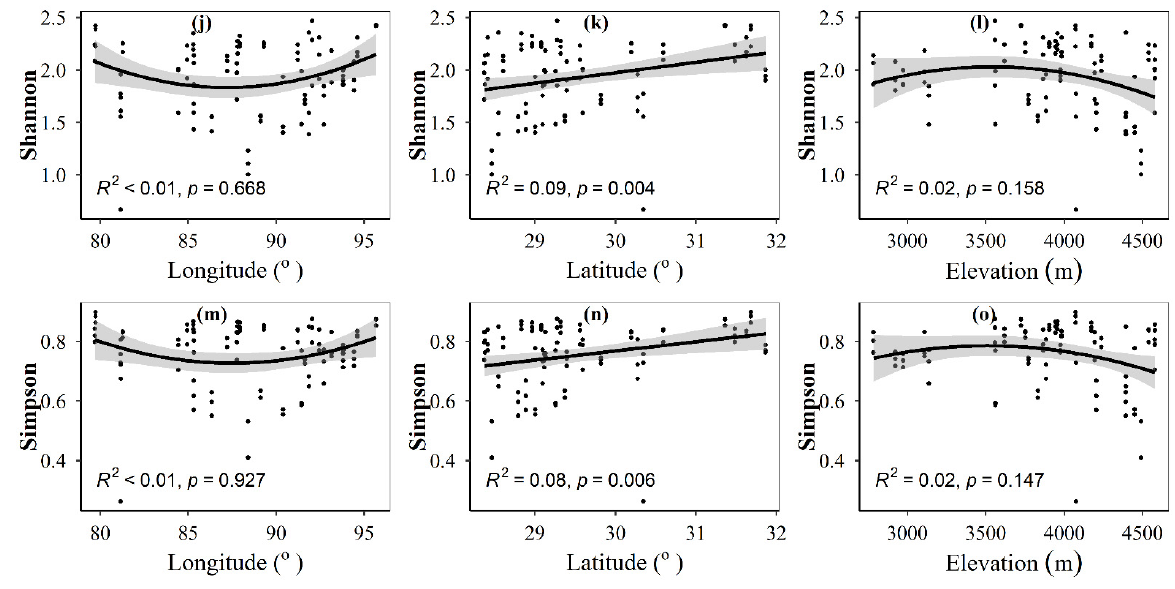
Figure A15. Relationships between functional α -diversity and geographic variables (longitude, lat- itude, and elevation) at 0–10 cm depth. ( a – c ) numbers of FunGuild at guild level (Guilds), ( d – f ) Chao1, ( g – i ) ACE, ( j – l ) Shannon, and ( m – o ) Simpson.